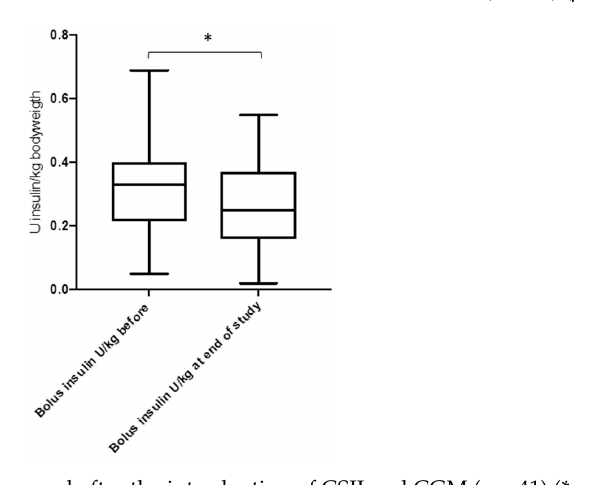
Figure 6. Bolus insulin dose before and after the introduction of CSII and CGM ( n = 41) (* p = 0.033). During the entire follow-up, local complications were reported as follows: kinking and/or blockage of the subcutaneous catheter in 34 (82%), consecutive high blood glucose >15 mmol/L in 25 (61%), bleeding at the infusion site in 12 (29%), and infection at the infusion site needing surgery in 2 (5%)